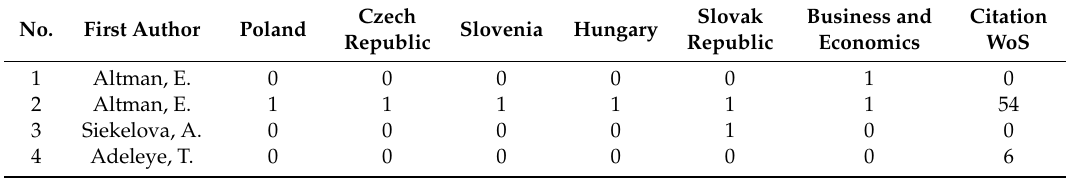
Table 7. Distribution of the leverage papers by country, areas, and citation count.